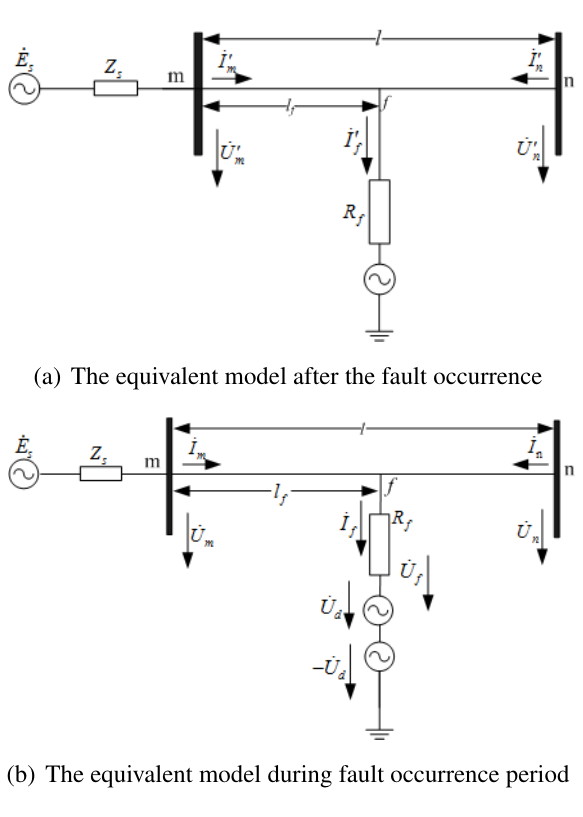
Figure 3. The equivalent model of faulted traction network